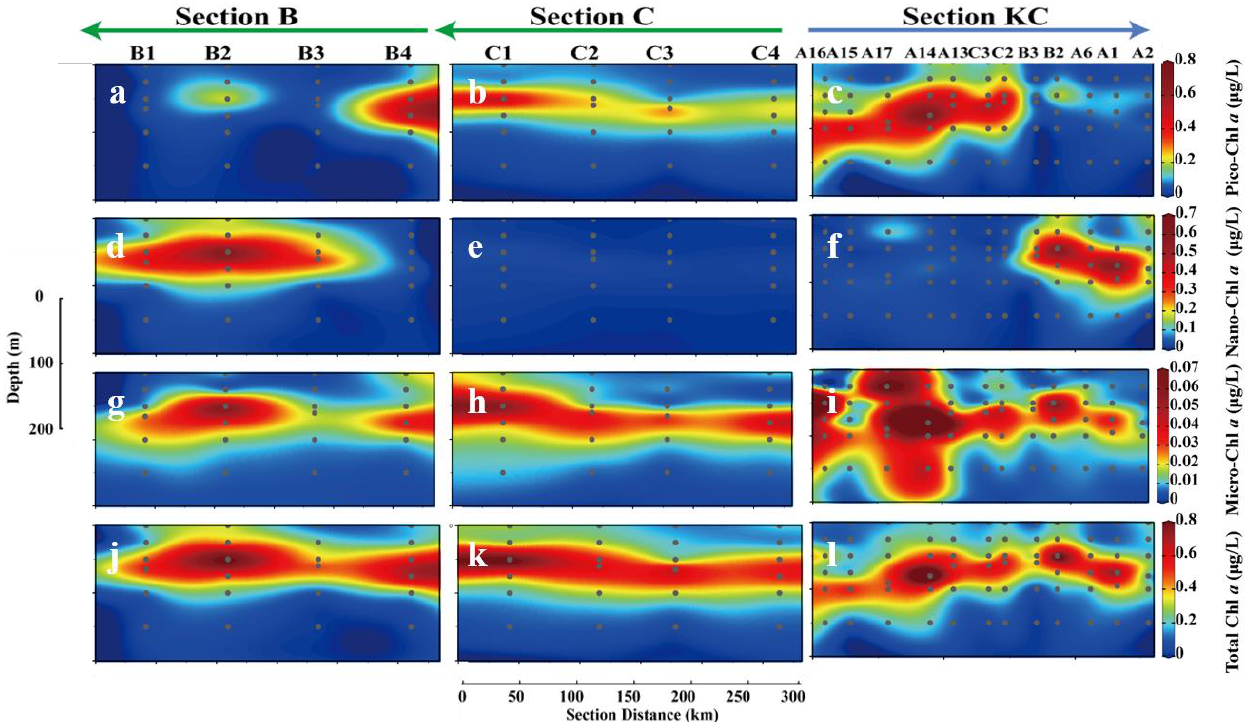
Figure 6. Vertical distribution of Chl a in section B, C, and KC. (pico-Chl a ( a – c ), nano-Chl a ( d – f ),